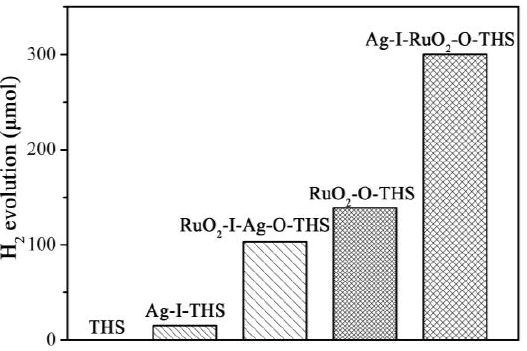
Figure 6. Photocatalytic activities of H 2 evolution on THS loaded by the cocatalysts with different spatial dispersion.